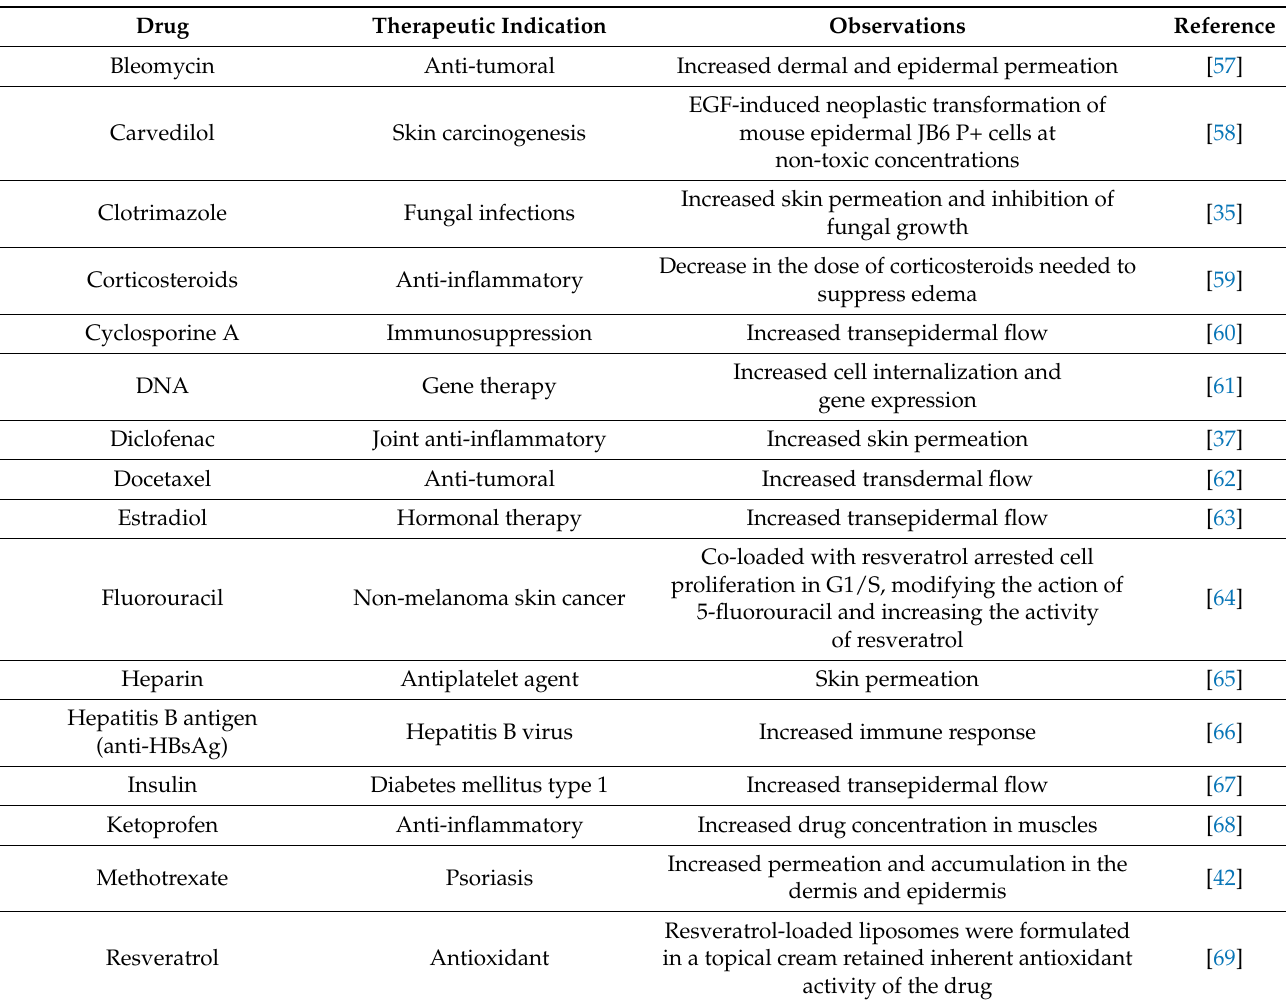
Table 2. Example of several APIs loaded in elastic/ultra-deformable liposomes for transdermal applications.